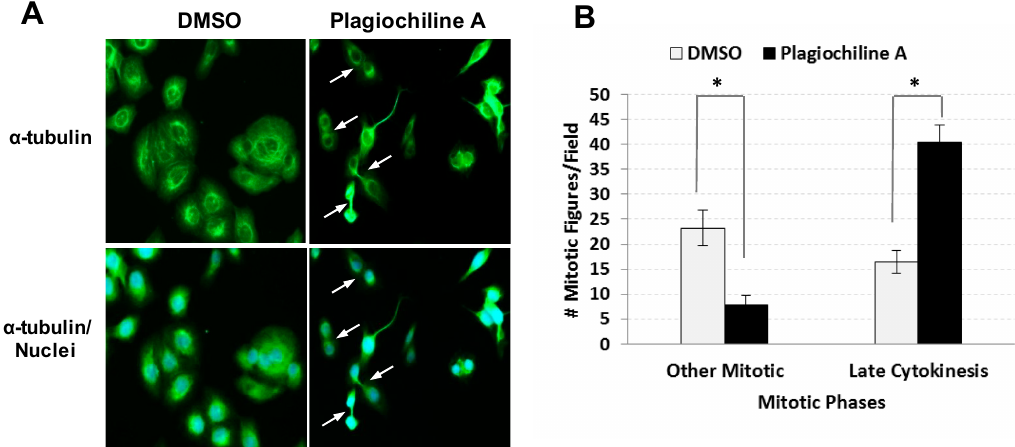
Figure 2. Fluorescence microscopy indicates defective cytokinesis in DU145 cells treated with plagiochiline A. DU145 cells were plated on glass cover slips and incubated 24 h at 37 °C. Cells were then treated for 48 h with 5 µM plagiochiline A or vehicle control (DMSO). Cells were washed with PBS, fixed with 4% paraformaldehyde, and permeabilized with 1% Triton X-100. Nuclei were stained with 4 ′ 6-diamidino-2-phenylindole (DAPI, blue) and α -tubulin was stained using anti- α -tubulin antibody labeled with fluorescein isothiocyanate (FITC, green). ( A ) Representative photomicrographs with arrows indicating cells arrested at late cytokinesis (i.e., nascent daughters remain attached by intercellular bridges). ( B ) Graph showing the number of mitotic figures observed per field examined (500 cells). Columns represent the mean of four independent experiments with bars representing standard error. Comparing plagiochiline A-treated vs. vehicle control cells, the increase in late cytokinesis and the decrease in other mitotic figures were statistically significant (*, P = 0.001 and 0.0084, respectively).